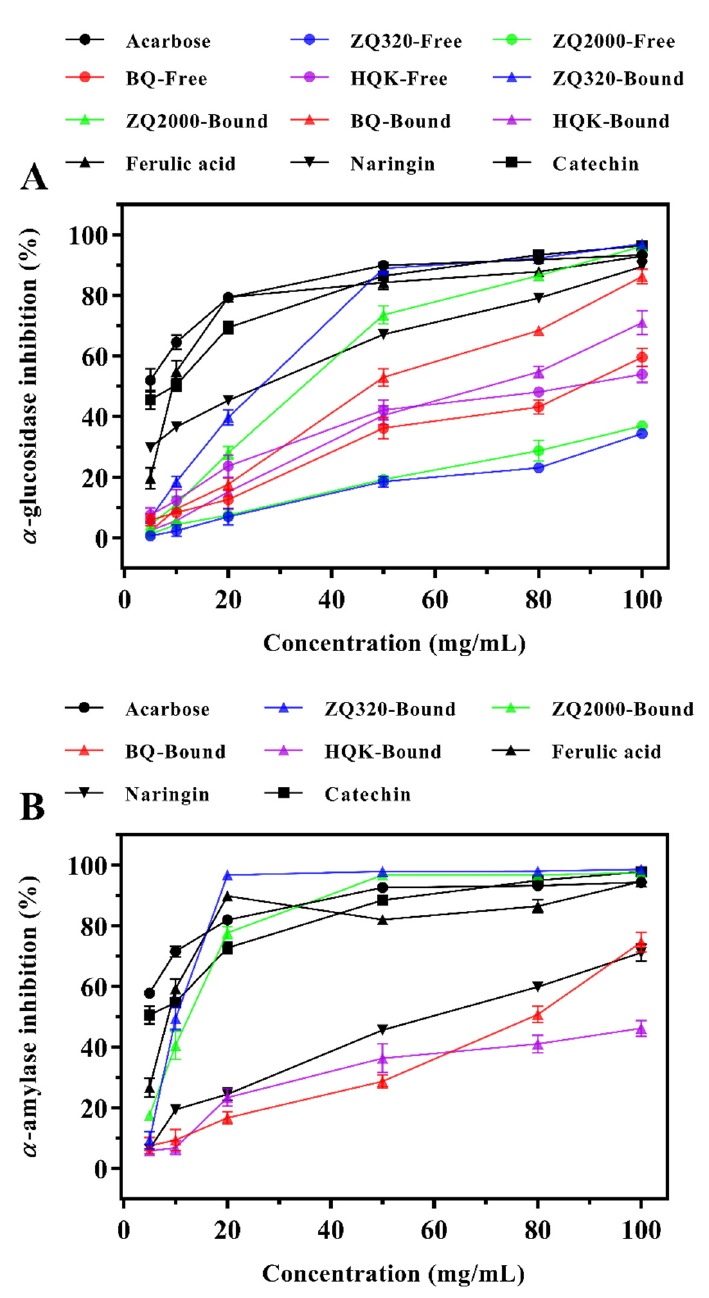
Figure 2. α -glucosidase ( A ) and α -amylase inhibitory activity ( B ) of free and bound fractions of four highland barley varieties (mean ± SD, n = 3). Table 3. The median inhibition dose (IC 50 ) of α -glucosidase and α -amylase inhibitions on four highland barley varieties (mean ± SD, n = 3).